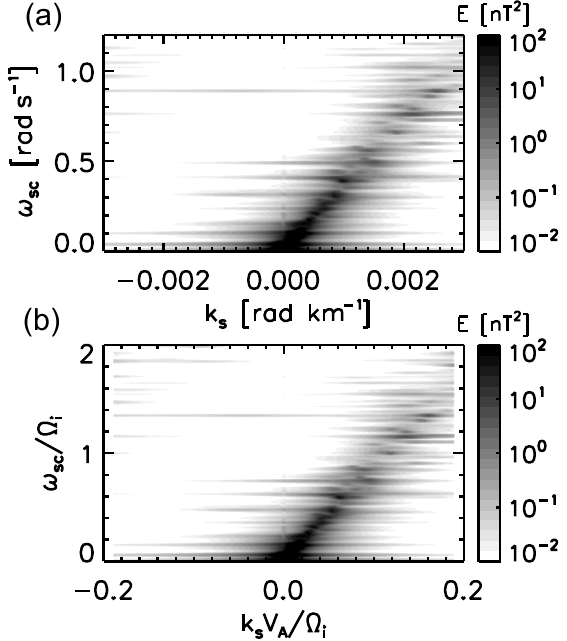
Figure 4. Eulerian (spacecraft-frame) energy spectrum for magnetic field fluctuations in the solar wind in the streamwise wavenumber– frequency domain. The measurements of Cluster spacecraft on a time interval of 17 March 2005, 10:00–12:00UT, are used. The spectra are displayed in physical units (radians per kilometer for the wavenumber and radians per second for the frequency) in the upper panel and in normalized units using the ion inertial length V A /(cid:127) i = 63kmrad − 1 and the ion gyrofrequency (cid:127) i = 0 . 66rads − 1